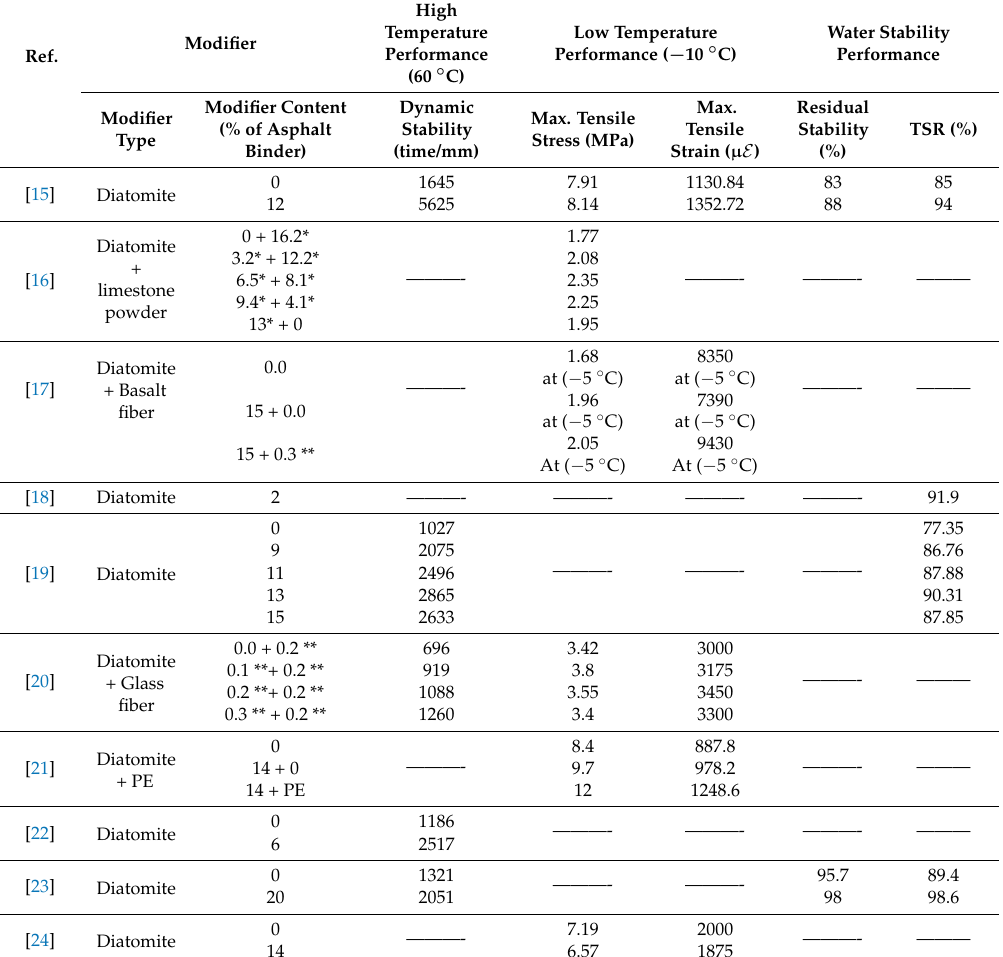
Table 2. Part of summary of diatomite modified asphalt mix for improving pavement performance [15–24].